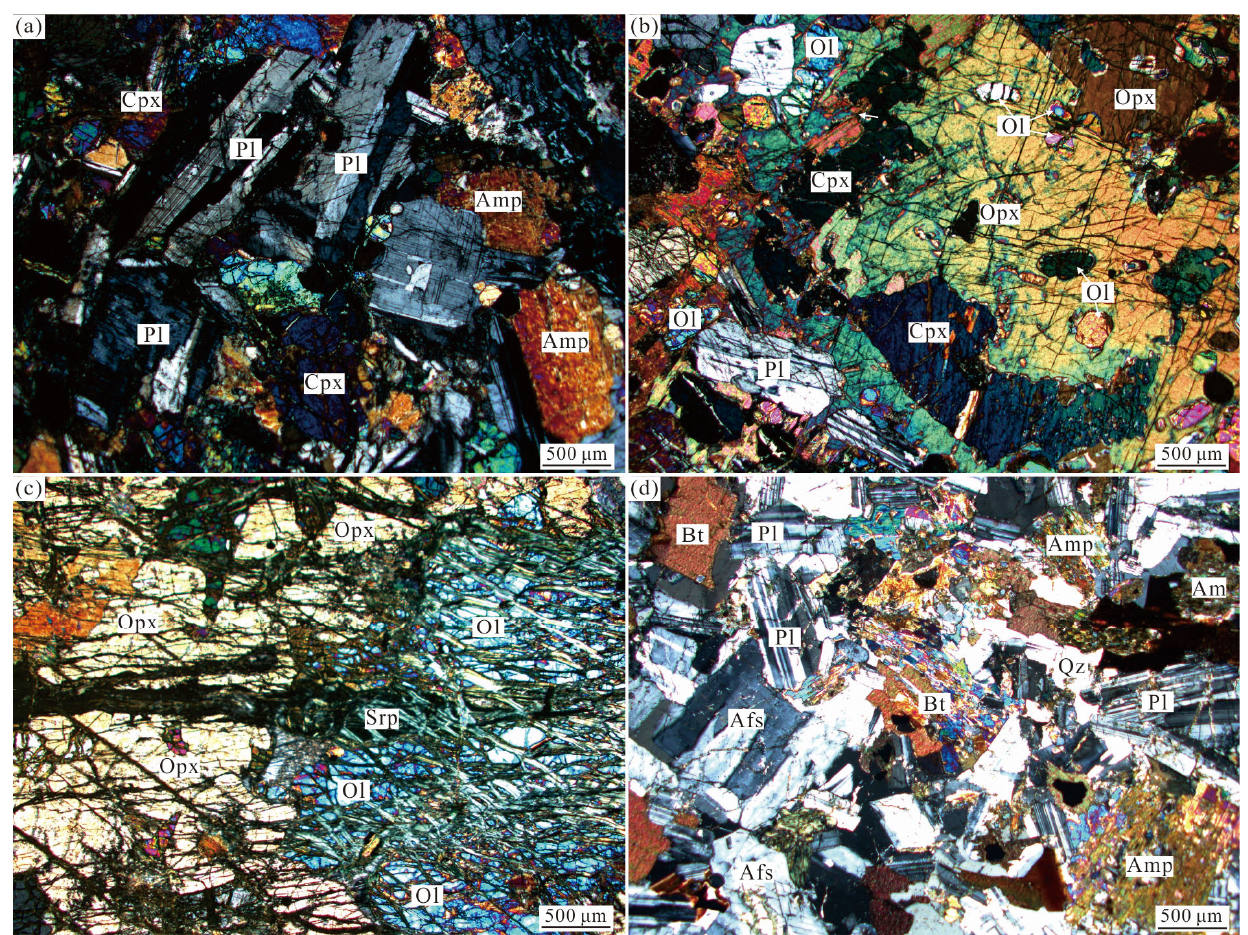
Figure 5. Representative photomicrographs of mafic–ultramafic rocks and diorite (cross-polarized transmitted light). ( a ) Gabbro. ( b ) Olivine websterite. ( c ) Lherzolite. ( d ) Diorite. The mineral abbreviations are after [39]: Pl—plagioclase; Cpx—clinopyroxene; Amp—amphibole; Ol—olivine; Opx—